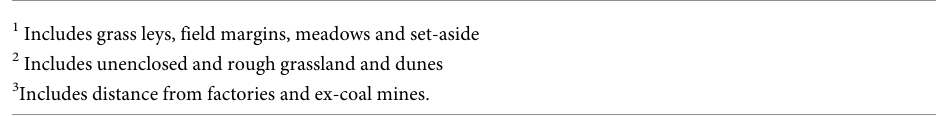
Surface 1 Includes grass leys, field margins, meadows and set-aside 2 Includes unenclosed and rough grassland and dunes 3 Includes distance from factories and ex-coal